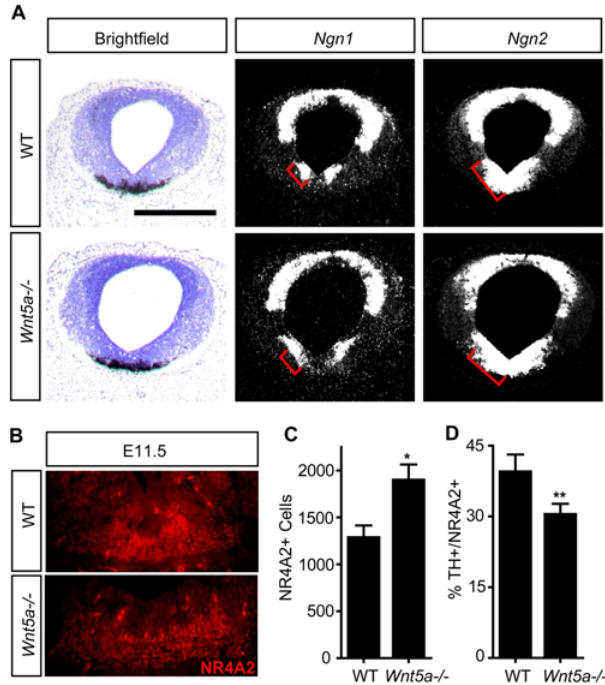
Figure 5. The ventral midbrain progenitor domains are expanded in Wnt5a 2 / 2 embryos. (A) Detection of Th , Ngn1 , and Ngn2 on representative serial coronal sections at the level of the midbrain of WT and Wnt5a 2 / 2 embryos at E11.5. Red brackets delimit the ventral Ngn1 and Ngn2 domain in the WT embryo, respectively. (Scale bar in A: 500 m m.). (B) Increase in NR4A2 + cells in the VM of Wnt5a 2 / 2 mice, which occupy a broader region laterally and dorsoventrally. (C) A 47% increase in the number of NR4A2 + cells was detected in the Wnt5a 2 / 2 mice at E12.5 (unpaired t-test, p=0.044, WT N=3, Wnt5a 2 / 2 N=4). (D) Analysis of the proportion of NR4A2 + cells differentiating into TH + DA neurons revealed that the differentiation of NR4A2 + precursors into TH + cells was impaired in the Wnt5a 2 / 2 mice at E12.5 (paired t-test, p=0.0098, N=3).